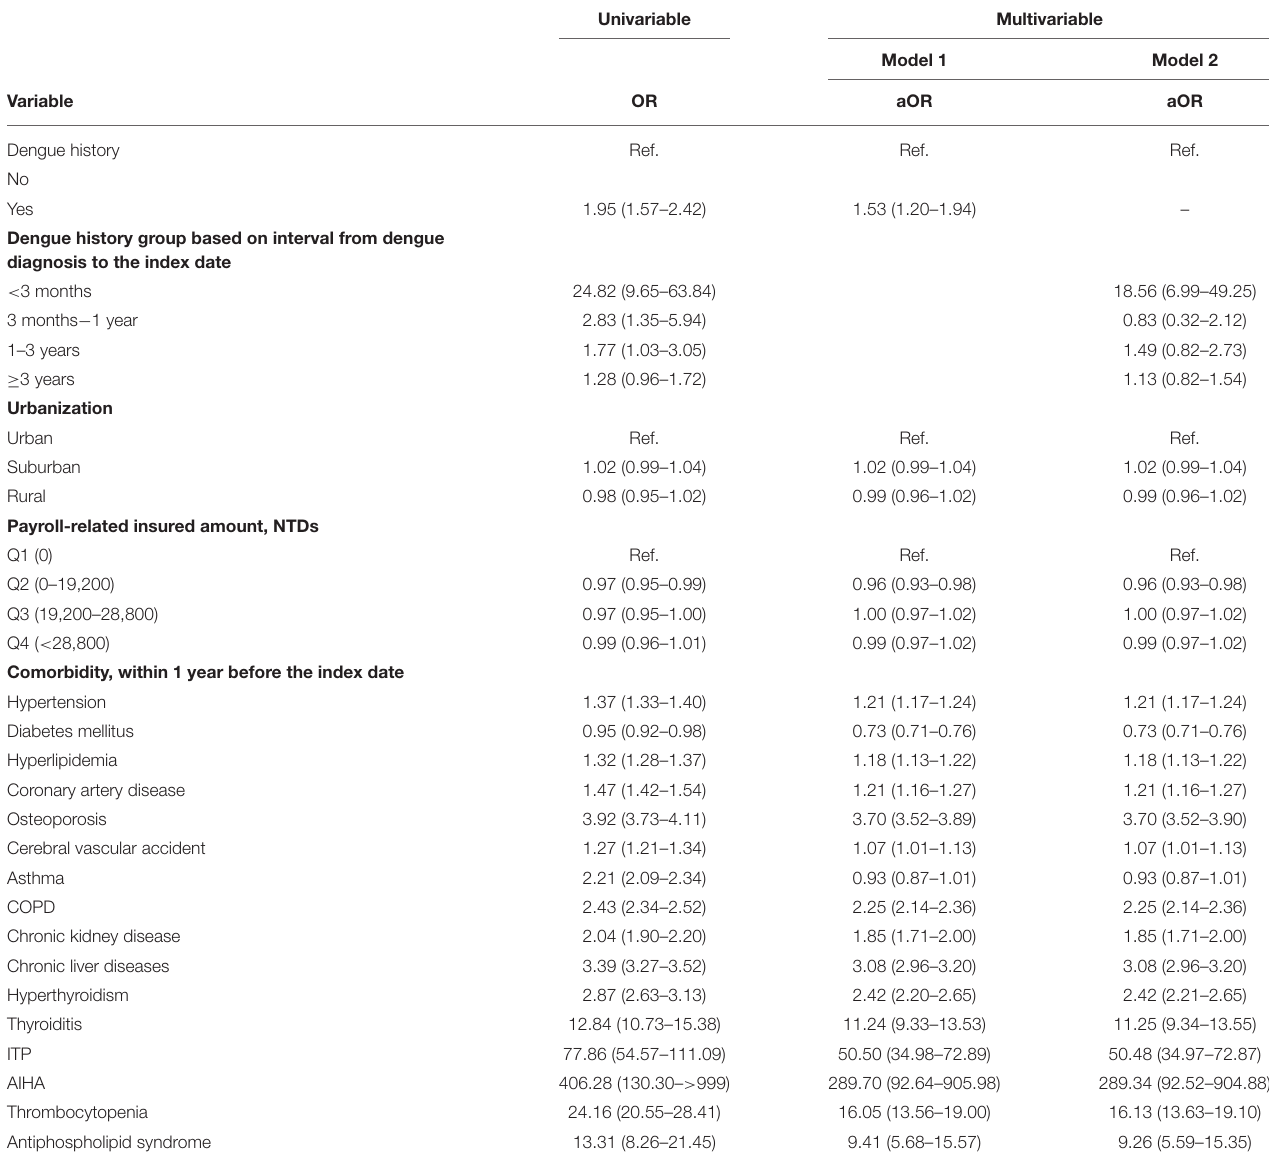
TABLE 2 | Associations between variables and the risk of